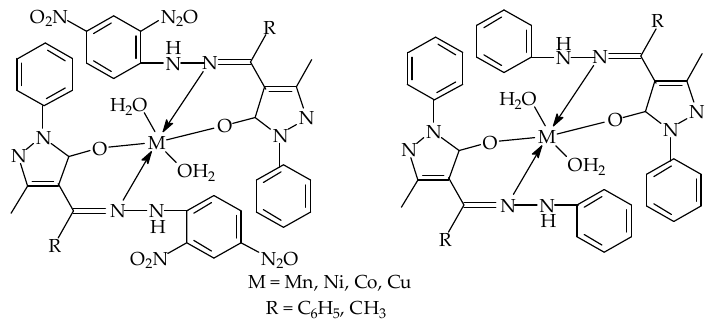
Figure 15. Proposed structure schemes of phenylhydrazone metal complexes.